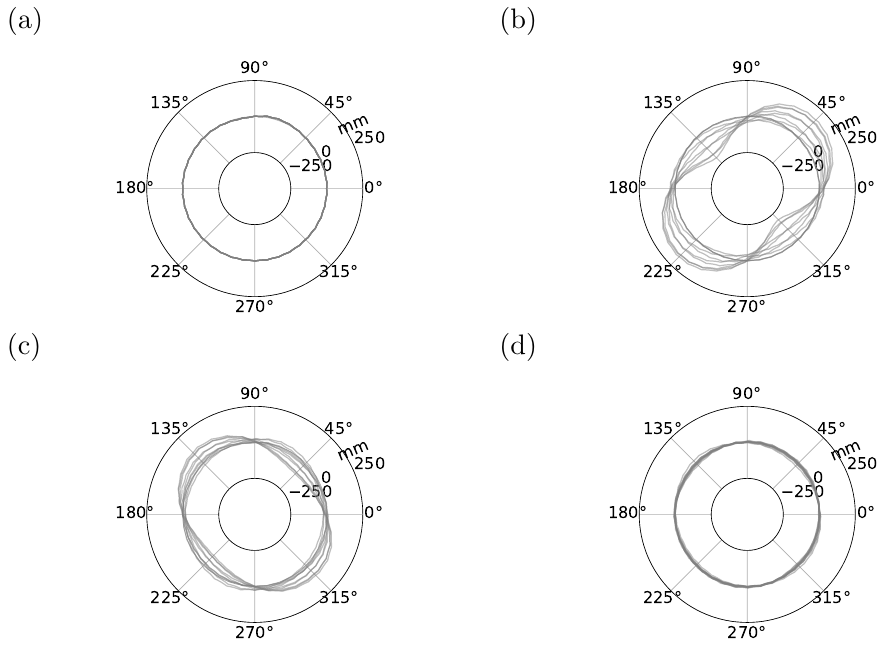
Figure 8. Roundness profiles from 10 evenly spaced cross-sections along the length axis of the roll for ( a ) undeformed initial geometry (stationary) ( b ) deformed initial geometry (rotating) ( c ) undeformed optimized geometry (stationary) and ( d ) deformed optimized geometry